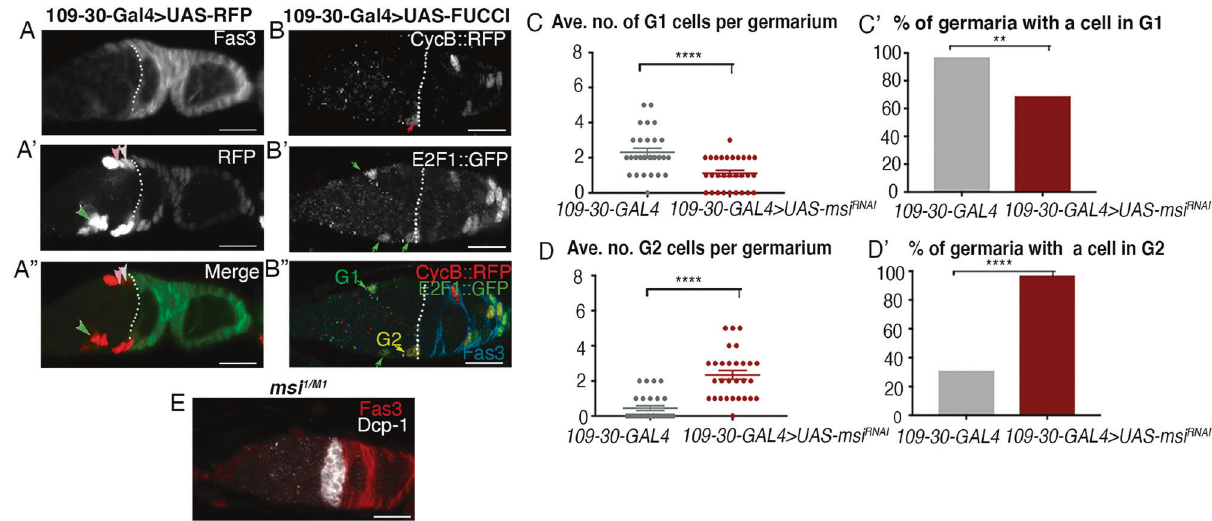
Fig. 5 Loss of Msi function in somatic cells causes cell cycle defects and an increase in dying germline cysts in region 2a/b of germaria. A - A ” Confocal micrograph (projection of 3 planes from a z stack) showing a representative image of a 109-30-Gal4 > UAS-RFP adult germarium. Dotted line represents the Fas3 expression boundary. A FSC in each of layers 1 and 2 (light pink and medium pink arrowheads respectively) and a posterior EC (green arrowhead) that are expressing RFP are labelled in ( A ’ ) and ( A) ” . B Confocal micrograph showing a representative image of a 109-30-Gal4 > UAS FUCCI adult germarium. A CycB::RFP-positive cell (red arrow), E2F1::GFP positive cells (green arrows), A G2 cell (yellow arrow in B ” ) and G1 cells (green arrow in B ” ) anterior to the Fas3 expression boundary (dotted line) are labelled. C Scatterplot showing a signi fi cant difference in the average number of cells (±SEM) in G1 within region 2a – 2b of germaria dissected from 109-30-Gal4 (2.31 ± 0.23, N = 29) and 109-30-Gal4 > UAS-msi RNAi (1.18 ± 0.16, N = 29) (Welsh ’ s two - tailed t test p < 0.0001) adults. C ’ Column graph showing a signi fi cant decrease in the % of 109-30-Gal4 > UAS-msi RNAi germaria with at least one cell in G1 (69%; N = 29; Chi - square p = 0.005) when compared to 109- 30-Gal4 germaria (97%). D Scatterplot showing a signi fi cant difference in the average number of cells (± SEM) in G2 within region 2a-2b of germaria dissected from 109-30-Gal4 (0.45 ± 0.14, N = 29) and 109-30-Gal4 > UAS-msi RNAi (2.35 ± 0.25, N = 29) (Welsh ’ s two-tailed t test p < 0.0001) adults. D ’ column graph showing signi fi cant increase in the % of msi RNAi ; 10930 Gal4 (97%; N = 29; Chi-square p < 0.0001) mutant